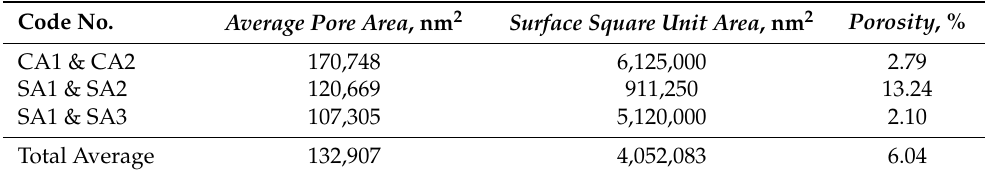
Table 2. Summary of average pore area, surface unit area and porosity. Code No.